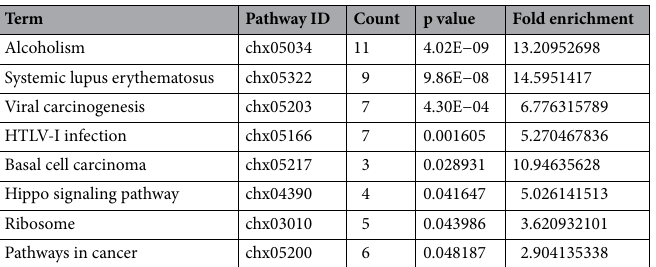
Table 6. KEGG pathway analysis of 160 DE